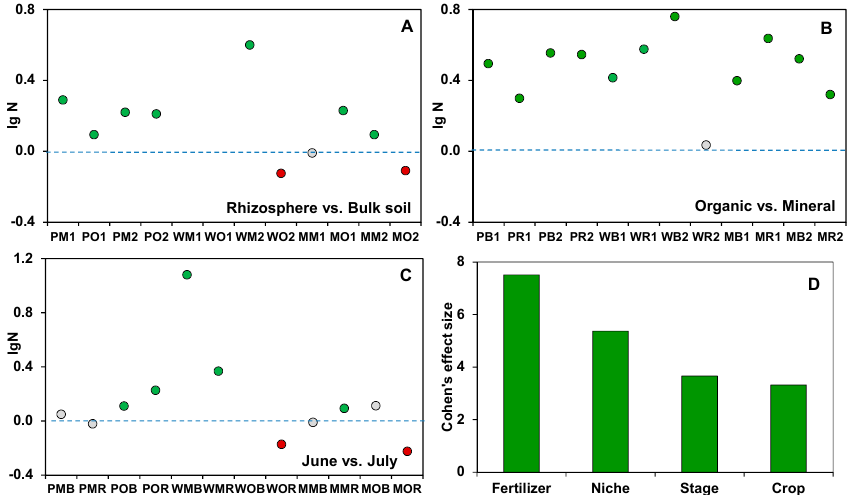
Figure 1. Differences in fungal gene copies abundances between the treatments compared. Comparisons are ( A ) rhizosphere/bulk soil, ( B ) organic/mineral fertilization, and ( C ) two periods of sampling. The green dots indicate significantly higher fungal abundances in soils under compared treatments, red dots indicate significantly lower abundances, and grey dots indicate no statistically significant differences between treatments ( N = 3). All soil samples are indexed according to the scheme: plant–fertilizer system–soil niche–sampling period. The following indices were used